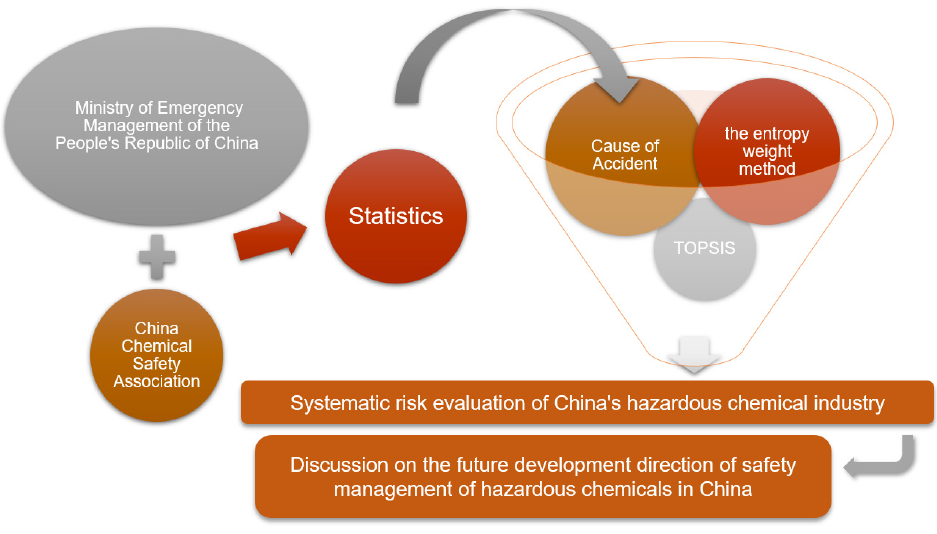
Figure 1. Methodological approach for accident analysis.